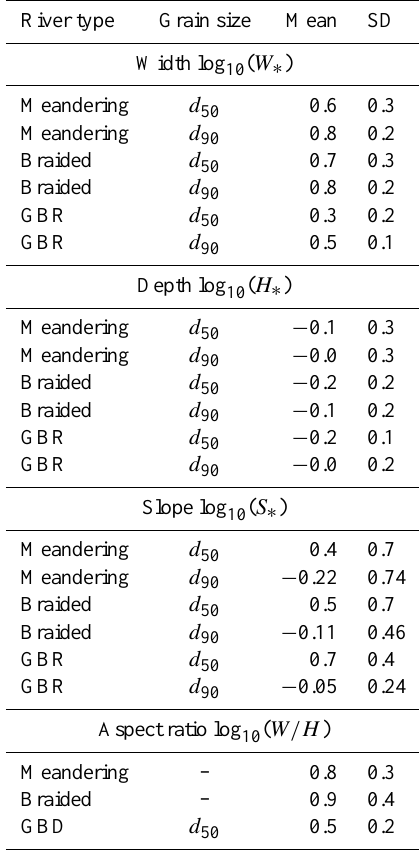
Table 3. Linear regressions on the log 10 of width and depth as func- tions of discharge and for two characteristic grain sizes. The confi- dence level is 95%. RMA: reduced major axis regression σ β stands for confidence interval on the slope of the regression β .